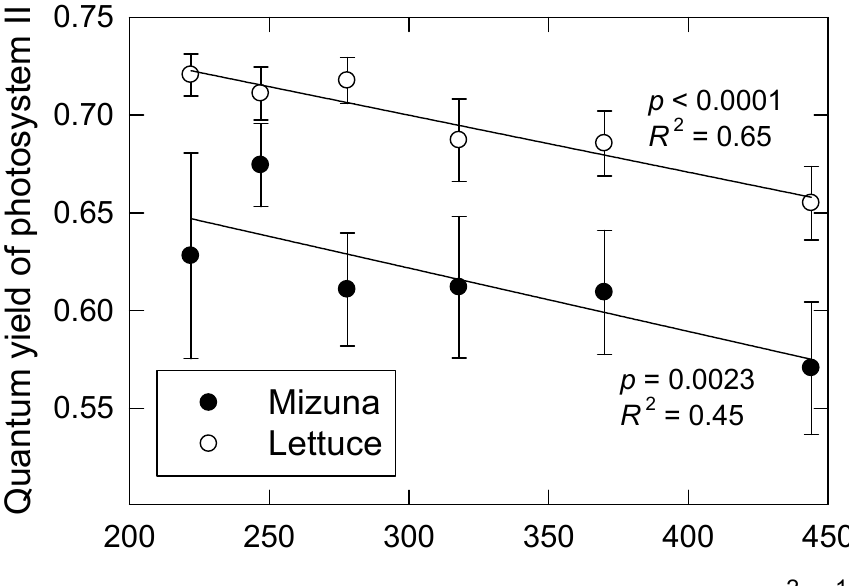
Figure 4. Quantum yield of photosystem II of lettuce and mizuna, grown under varying photosynthetic photon flux densities with different photoperiods, result in the same daily light integral (16 mol·m − 2 ·d − 1 ). Data were collected during the first experiment. Data points represent the mean ± SE ( n = 3). Lines indicate significant linear effects ( p < 0.05).